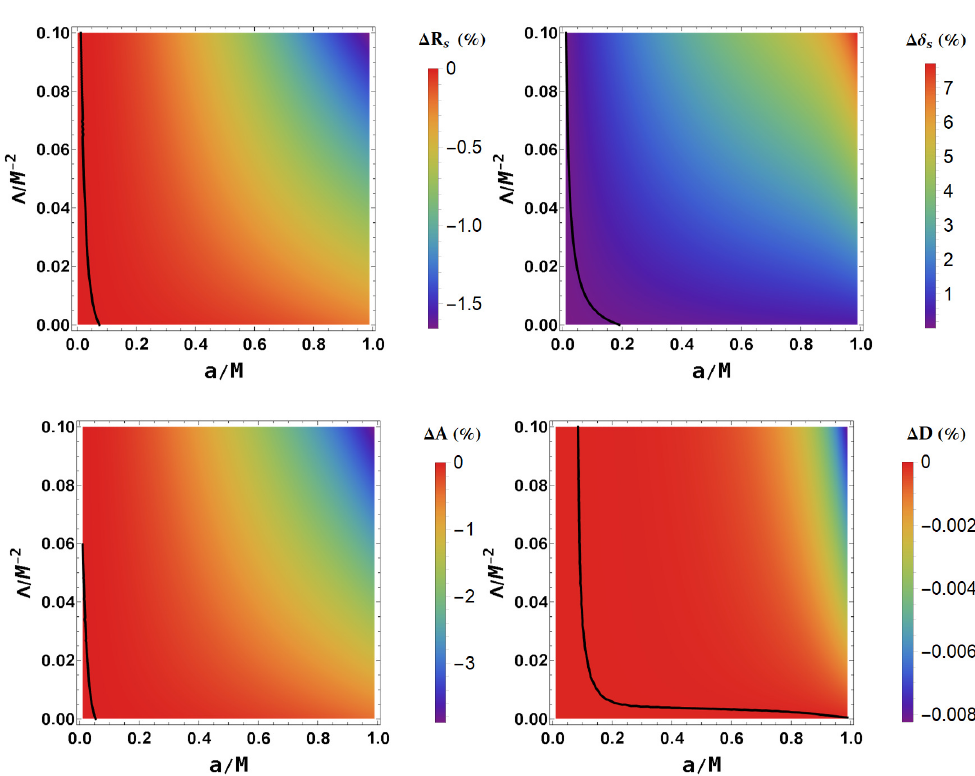
Figure 10. Relative difference ∆ O (%) between the shadow observables of the new Kerr–de Sitter black holes and the Kerr–de Sitter black hole at ( r 0 , θ o ) = ( 4 M ,90 ◦ ) . In the regions bounded within the black solid curves and the axes, the observables of the new Kerr–de Sitter black holes and the Kerr–de Sitter black hole are